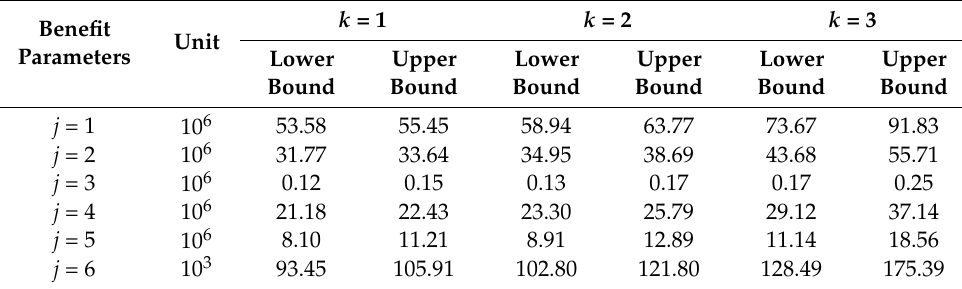
Table A2. Benefit/cost parameters (RMB/km 2